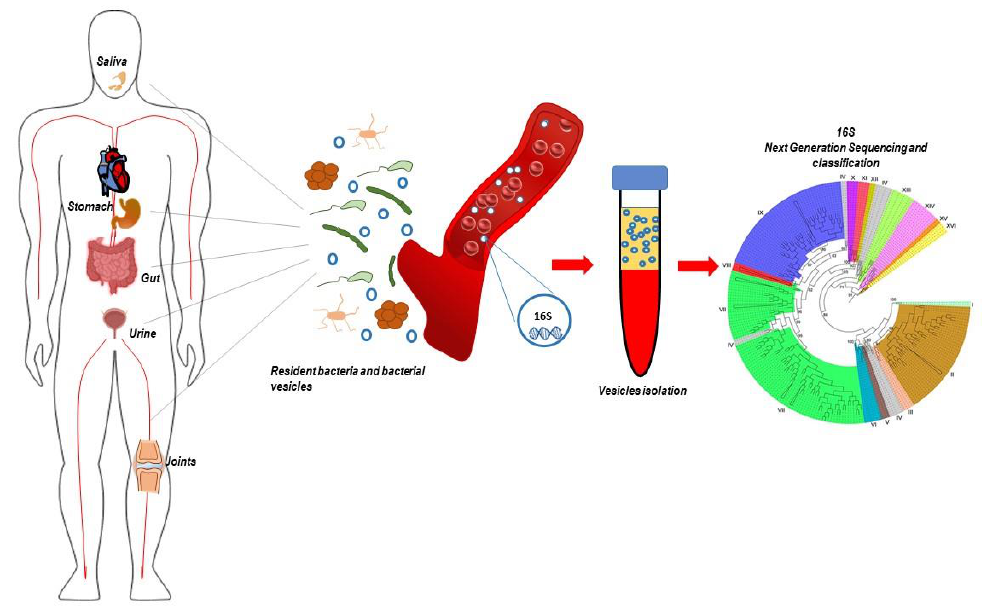
Figure 2. Circulating microbiome analysis. The figure depicts the proposed mechanism of classification of circulating microbiome, based on the isolation of RNA from bacteria-derived extracellular vesicles, amplification of 16S RNA, and Next-Generation Sequencing.